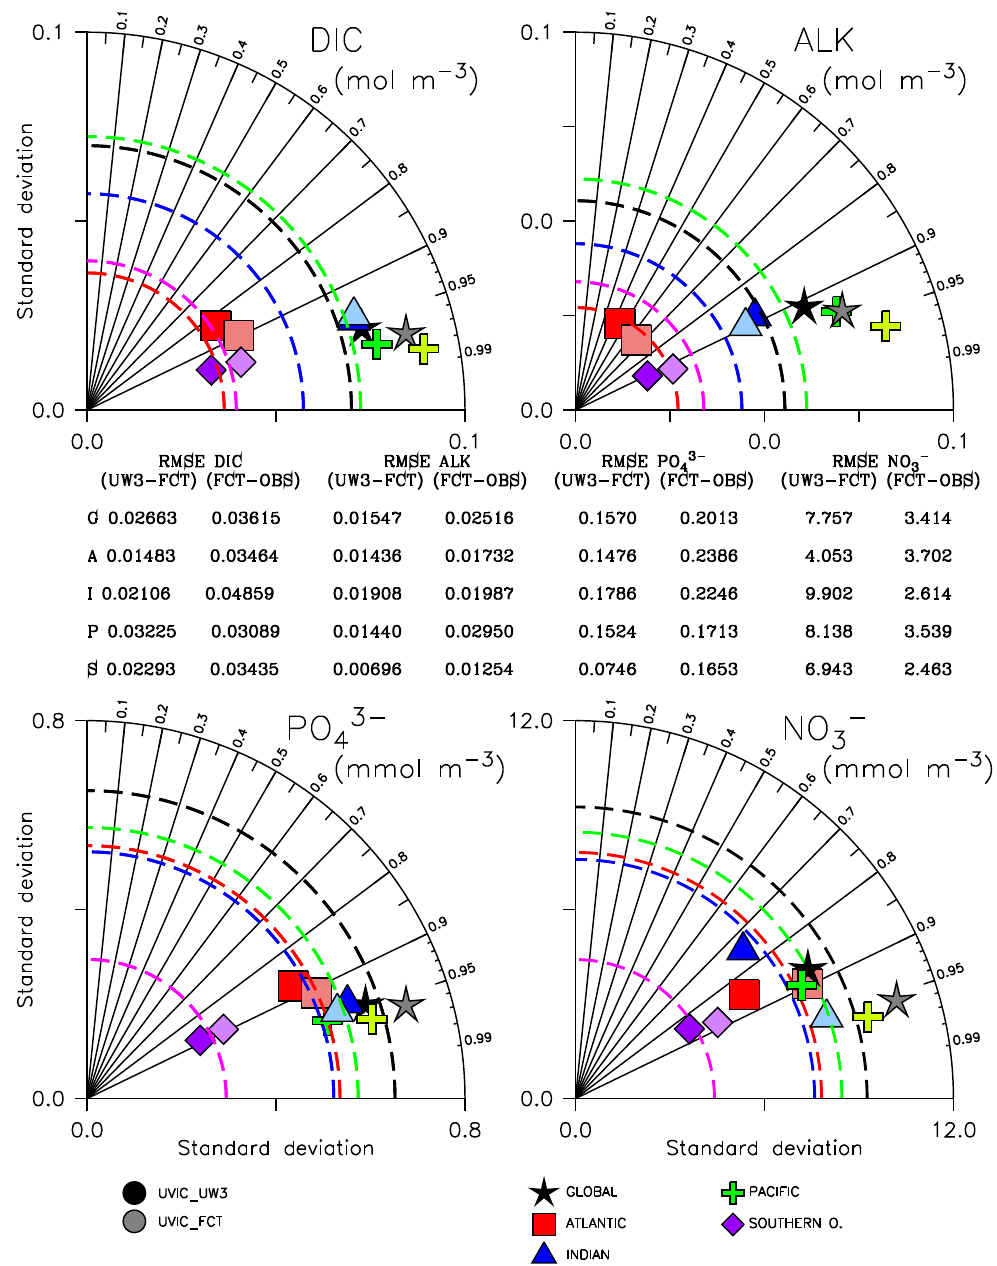
Figure A5. Taylor diagrams for various simulated biogeochemical quantities in comparison to observations (World Ocean Atlas climatology Garcia et al., 2010a, b) showing the impact of advection scheme. Different symbols and colors correspond to different ocean basins, with light shaded symbols representing UVIC_UW3 and dark shaded ones UVIC_FCT. For each symbol plotted, the azimuthal angle is the correlation coefficient between the simulated and observed field, with a correlation coefficient of “1” lying on the x axis, and the radial distance from the origin is the spatial standard deviation of that field. To avoid cluttering the diagram, we plot the standard deviation of the corresponding observation as a colored, dashed line so that the observation lies on the intersection of that line with the x axis. The distance between that intersection point and any plotted symbol is the centered RMS difference between the model and data. For clarity these RMS values are also tabulated in the